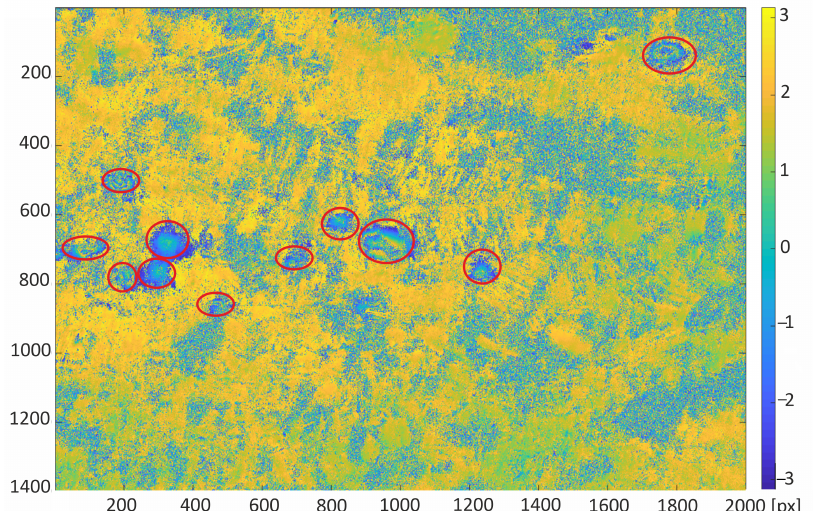
Figure 8. Differential interferogram of the first area with marked subsidence areas (red ellipses) calculated for the study area from satellite images taken on the 10th and 22nd of October 2016.